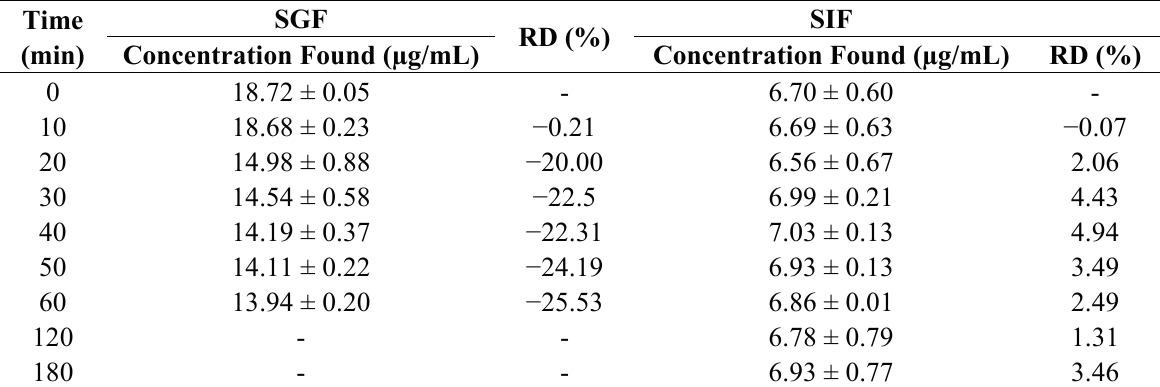
Table 4. Mitragynine stability in SGF and SIF (with